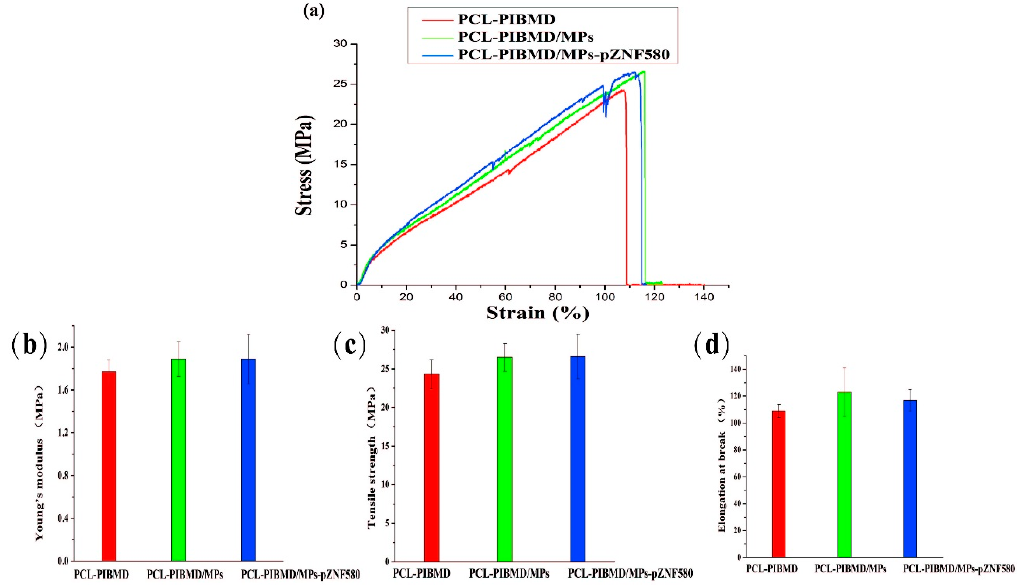
Figure 3. Stress–strain curves for electrospun PCL-PIBMD, PCL-PIBMD/MPs and PCL-PIBMD/MPs- pZNF580 meshes ( a ); Mechanical properties were evaluated: ( b ) Young’s modulus; ( c ) Tensile strength; and ( d ) Elongation at break. Error bars represent mean ± standard deviation (SD) ( p > 0.05).